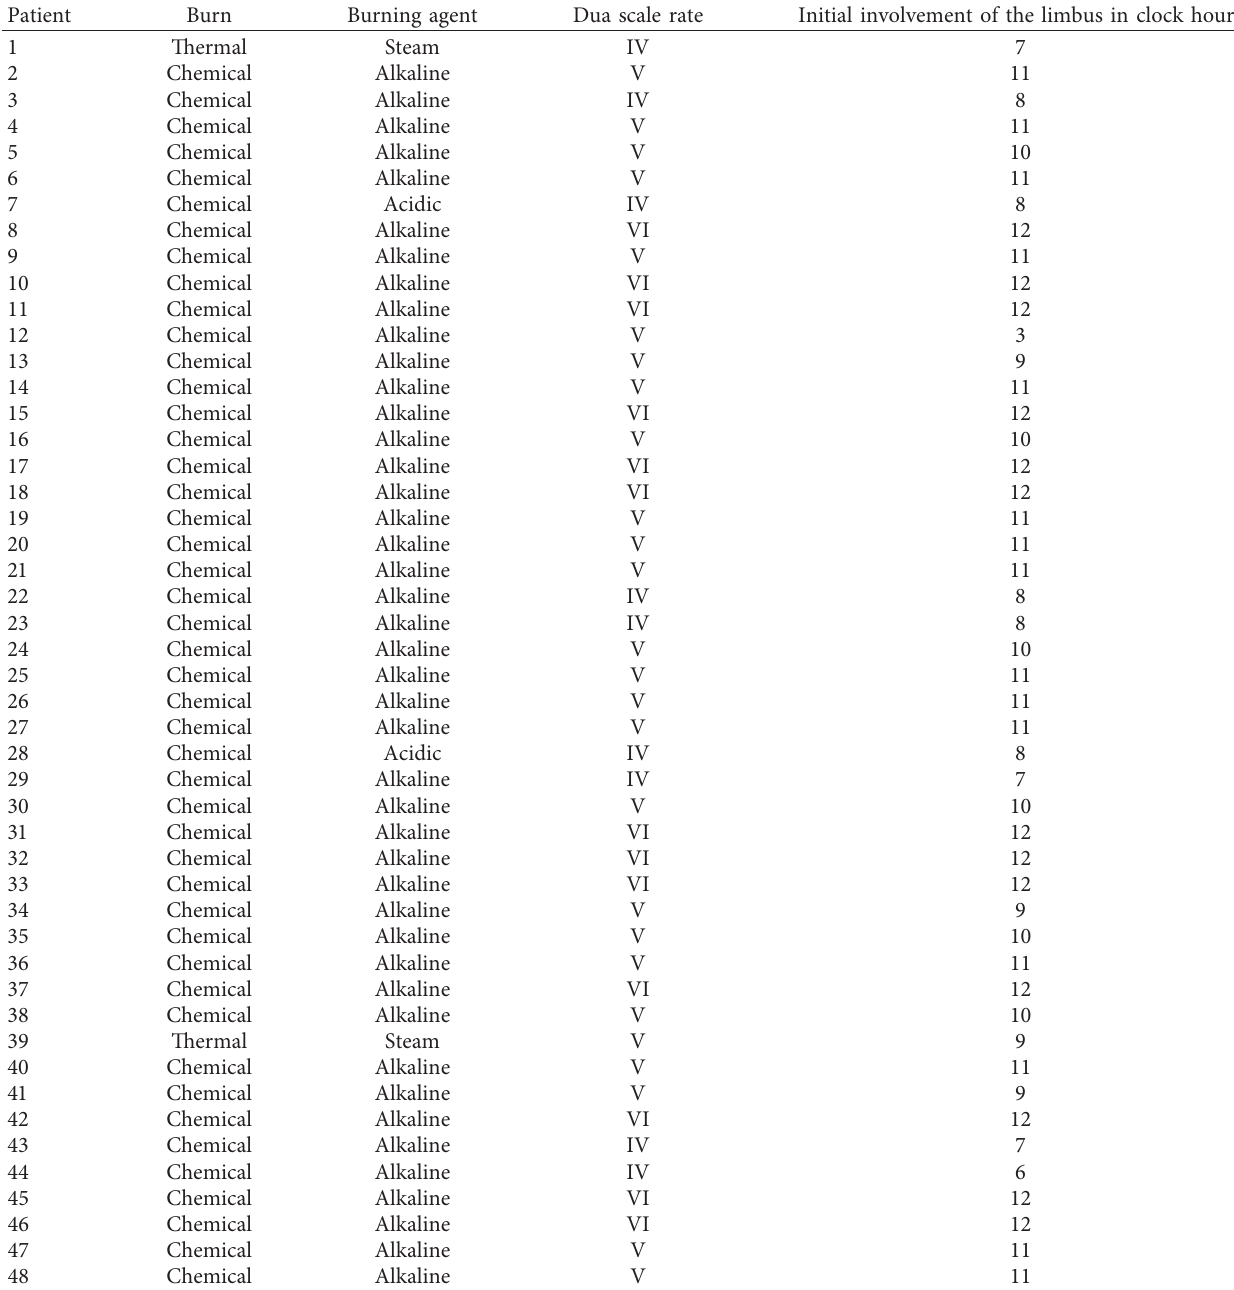
Table 1: Types of ocular burns and involvement of corneal surface in Dua’s scale and in clock hours of the limbus involvement in each